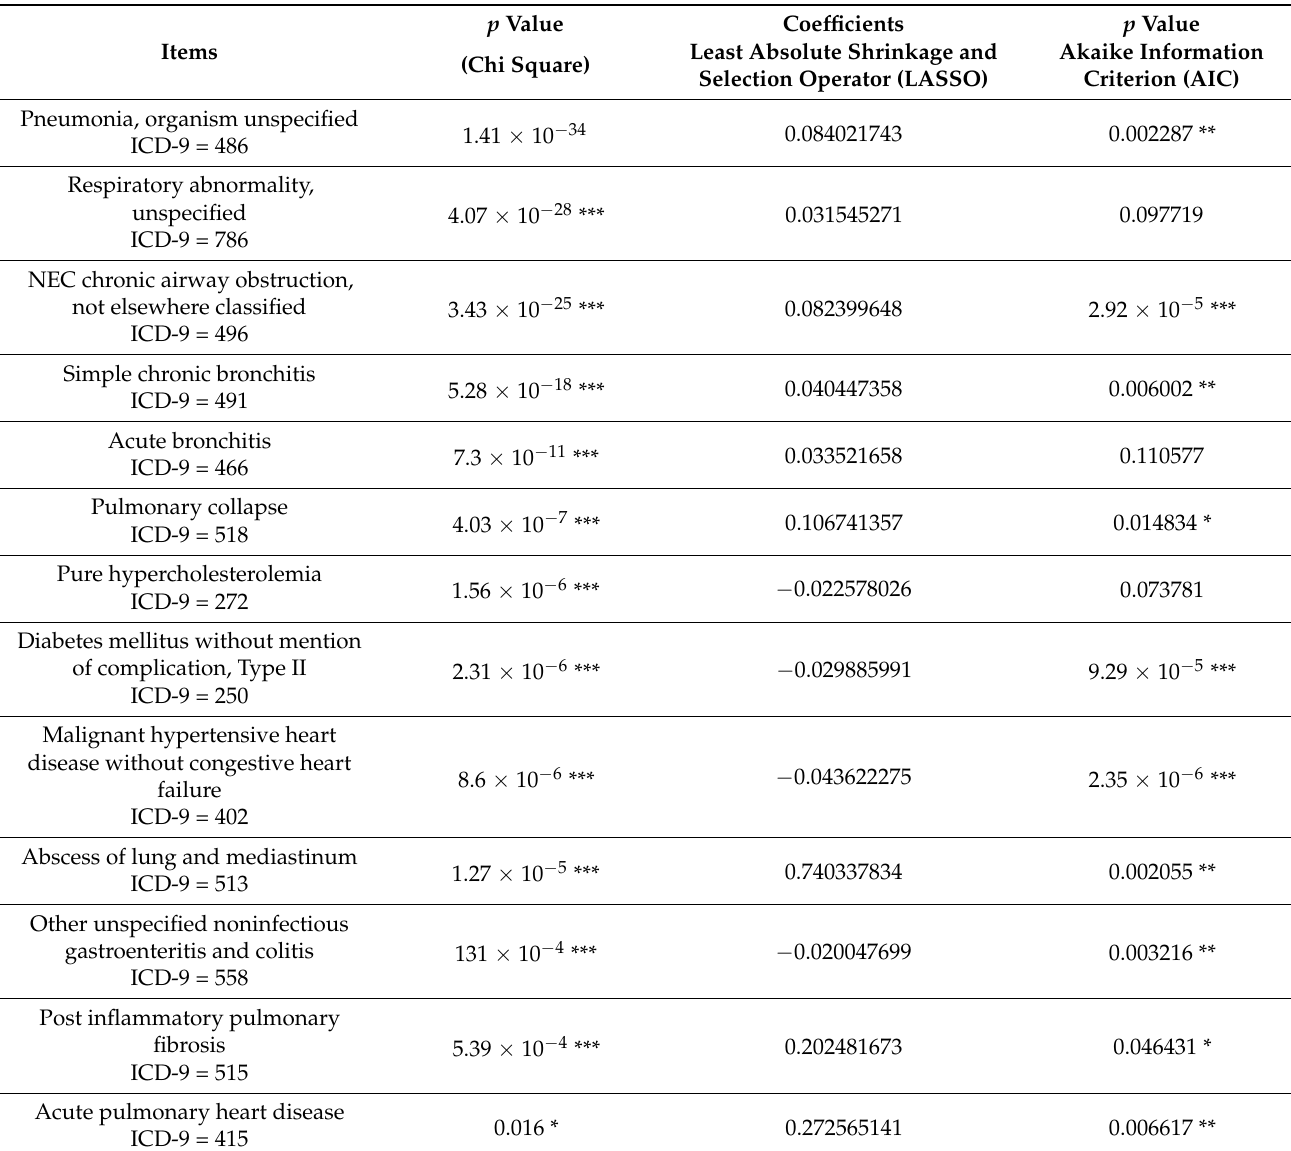
Table 3. The coefficient and p value of each